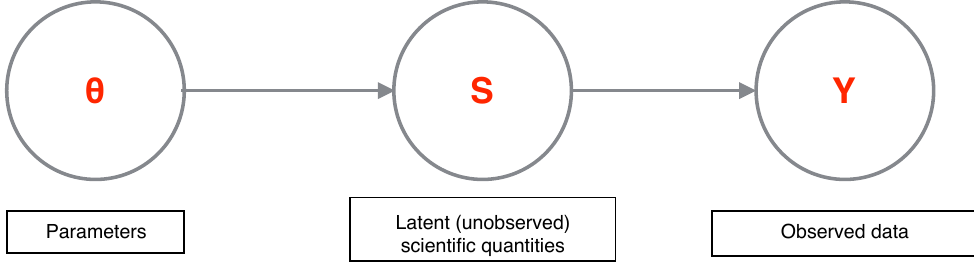
Figure 1. Schematic of a simple Bayesian hierarchical model; here, θ represents physical parameters, S represents unobserved scientific quantities of interest, and Y represents the observed